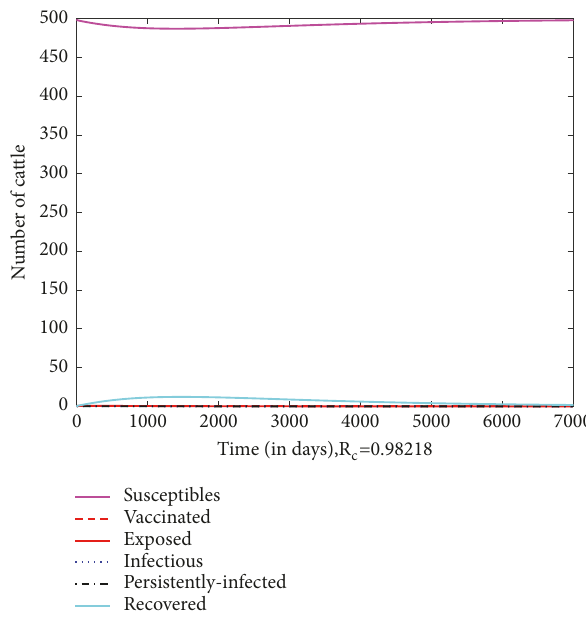
Figure 5: Number of cattle in each compartment with baseline parameter values in Table 1 with the assumption that 85.7 % of infectious cattle receive antibiotic treatment within 8 days ( 𝛼 𝑡 = = 1 , 1/8 − 1/56 ) without vaccinating healthy cattle ( 𝜌 = 0 ), 𝐼 0 𝑆 = 499 , and 𝑉 = 𝐸 = 𝑄 = 𝑅 = 0 , giving approximate 0 0 0 0 0 equilibrium values 𝑆 ∗ = 498 , 𝐸 ∗ = 𝐼 ∗ = 𝑄 ∗ = 0 , 𝑅 ∗ = 2 , and R = 0.9822 𝑐